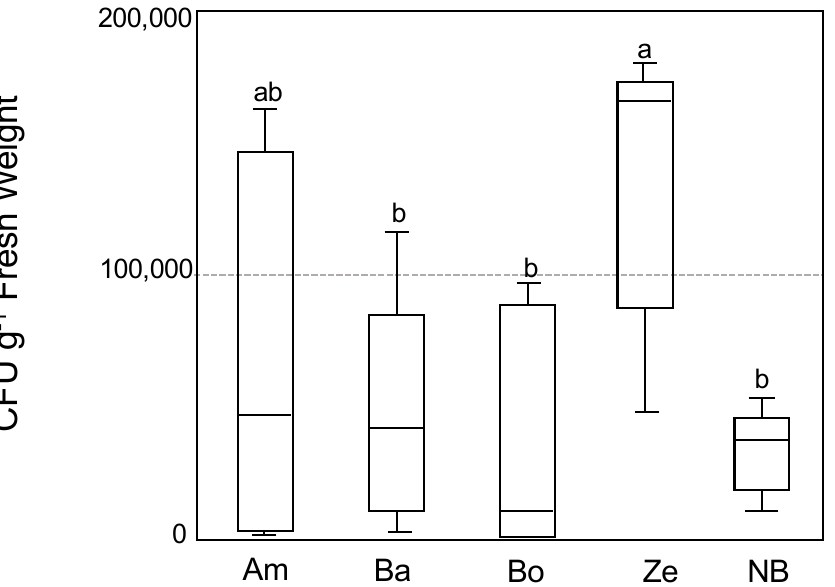
Figure 1. The endophytic colonization of Azospirillum sp. B510 on Japonica and Ghanaian rice. The endophytic colonization of DsRED-tagged B510 in the tissue of Ghanaian (Ex-Amantin (Am), Bawku-Market a (Ba), Ex-Boako (Bo), and Zebila (Ze)) and Japonica (Nipponbare (NB)) rice. Colonies were counted using dilution methods. Values presented are the average ± SD from 6 replicates of one plant each. Different letters indicate the significant differences between treatments (Student– Newman–Keuls (SNK) test, p < 0.05, n = 6).